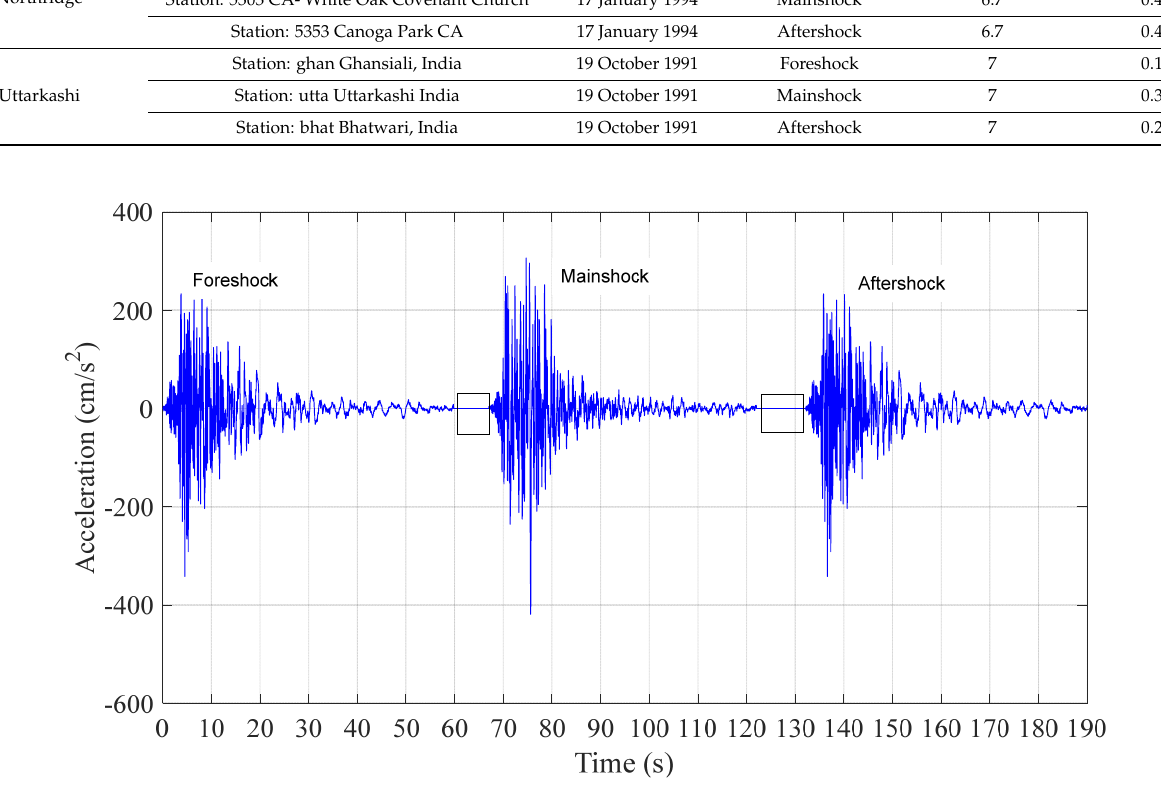
Figure 7. Seismic sequence history for the Northridge earthquake.